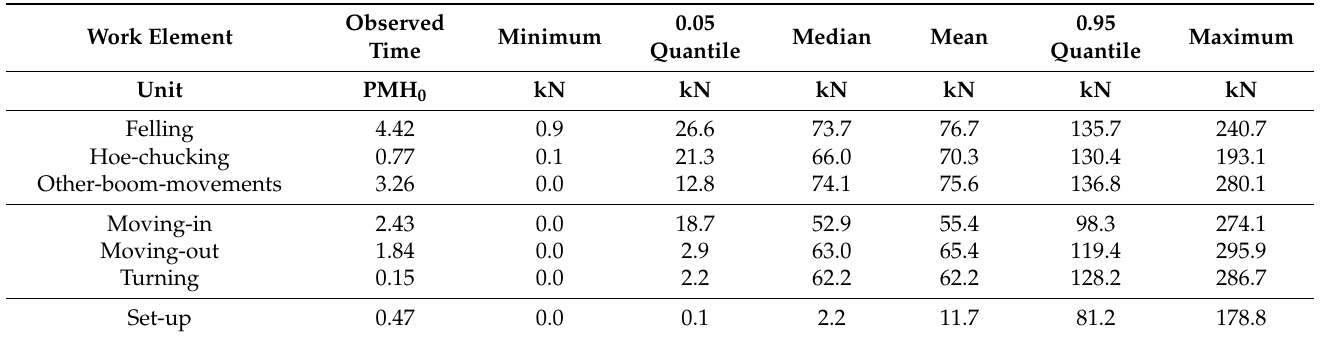
Table 1. Cable tensile forces recorded at the harvesting machine.